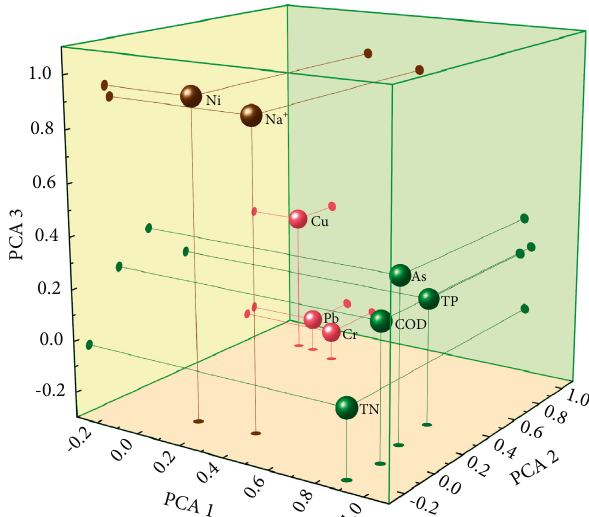
Figure 7: Three-dimensional diagram of the component